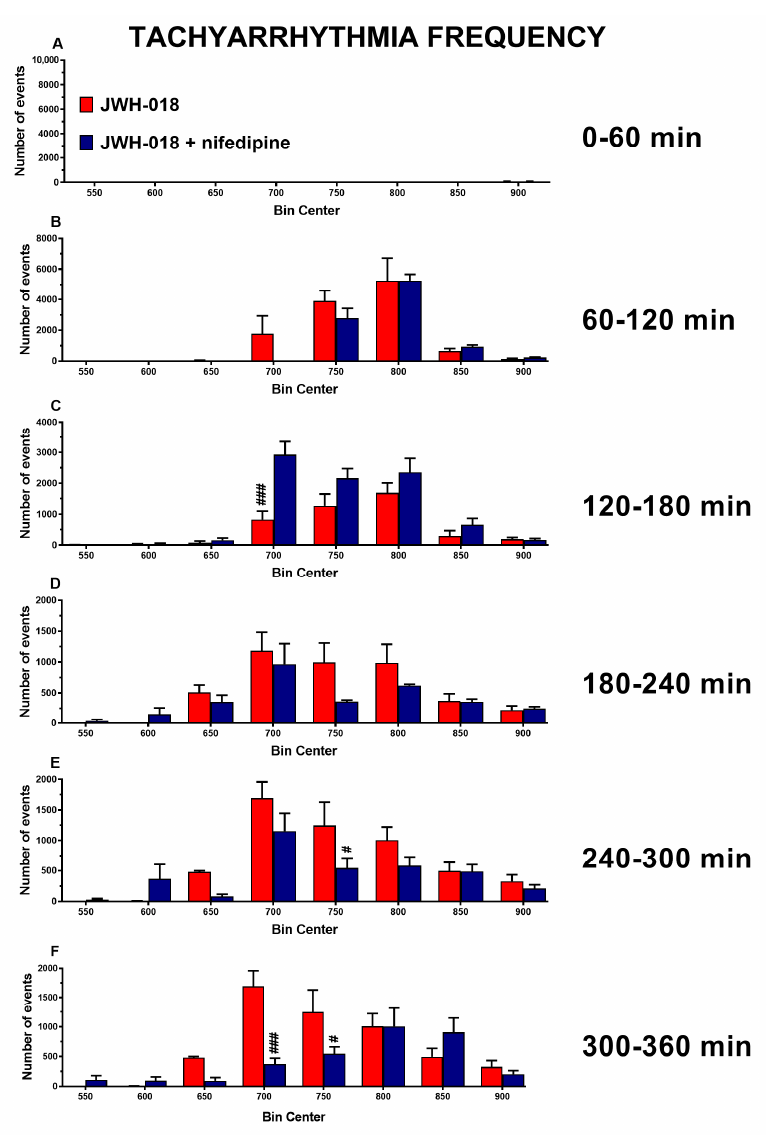
Figure 6. Frequency of tachyarrhythmia episodes between 0–60 ( A ), 60–120 ( B ), 120–180 ( C ), 180–240 ( D ), 240–300 ( E ), and 300–360 ( F ) minutes after administration of JWH-018 (6 mg/kg) or JWH-018 followed by nifedipine (5 mg/kg), expressed as number of events per mean heart rate value. Mean ± SEM of eight different evaluations for each group. Statistical analysis was performed by two-way ANOVA followed by Bonferroni’s test for multiple comparisons. # p < 0.05, ### p < 0.001 versus JWH-018 +